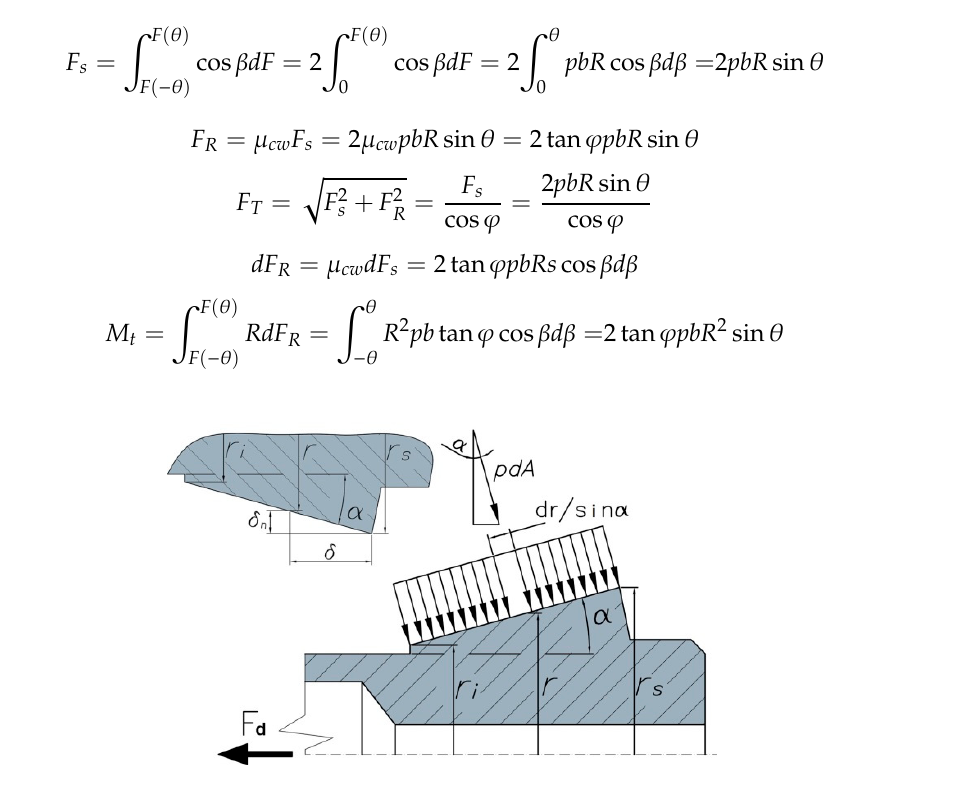
Figure 6. Cone–collet contact pressure.